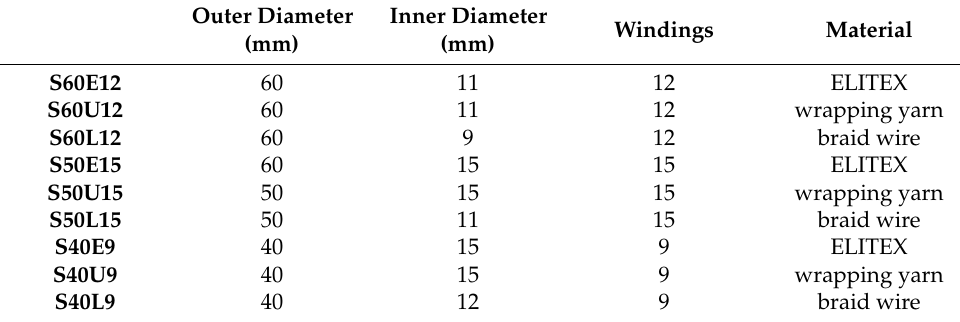
Table 3. Different coil geometries–tailored wire placement.